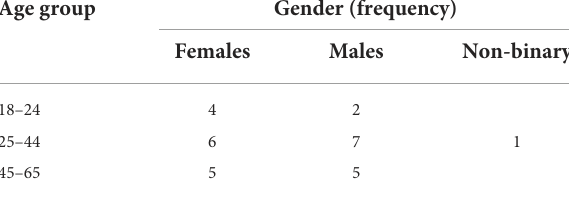
TABLE 3 Demographic information divided by gender and age ( n = 30).